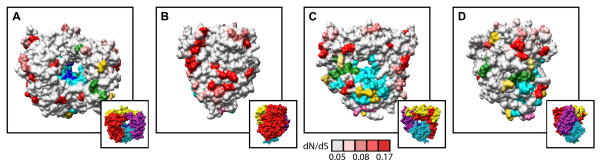
Location of diversifying residues and functional residues in the 3D polymerase. Front view (A), side view of fingers subdomain (B), back view (C), and side view of thumb subdomain (D) of the HRV14 3D polymerase structure (Love et al., 2004). Cyan, palm subdomain residues; blue, catalytic residues; green, residues implicated in VPg and CRE binding; pink, potential oligomerization interface I residues. Diversifying residues are shown in red, shaded according to their corresponding dN/dS values indicated by scale bar below panel C; yellow, diversifying residues that directly overlap functional residues. Insets A-D, provided for orientation to 3D polymerase subdomains: red, fingers subdomain; cyan, palm subdomain; purple, thumb subdomain; yellow, N-terminal residues.